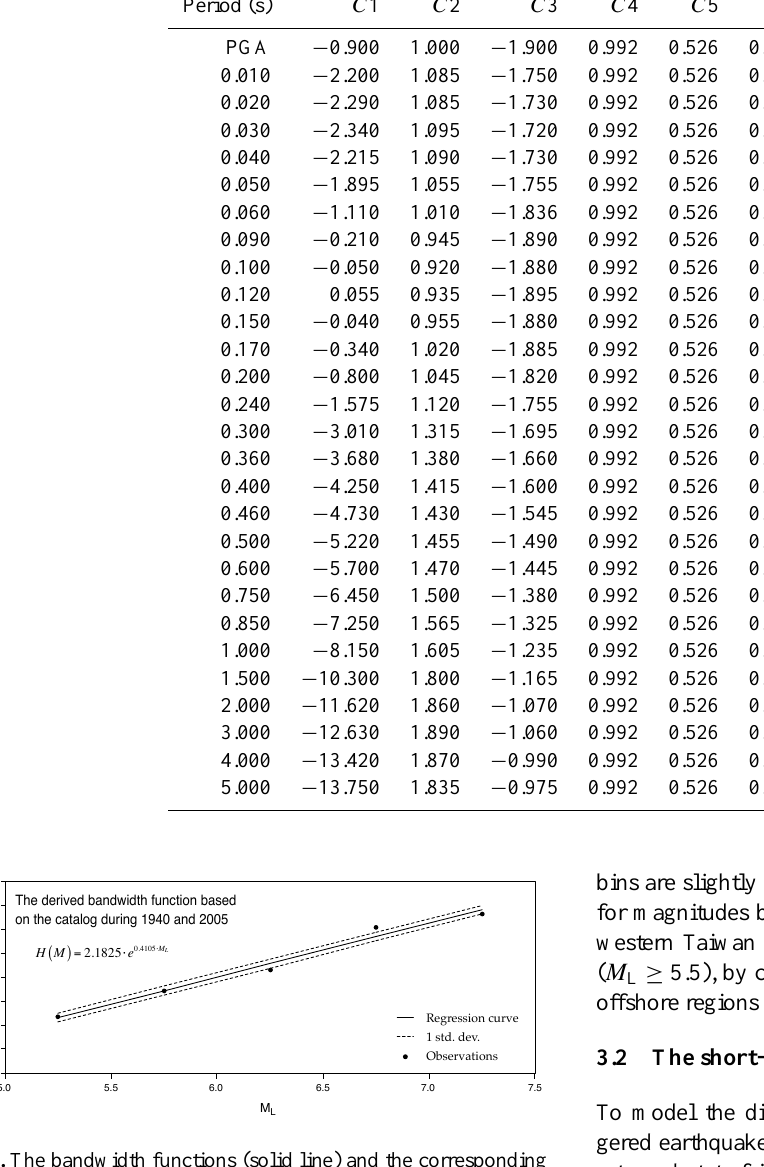
Fig. 3. The bandwidth functions (solid line) and the corresponding standard deviation (dashed lines) obtained by the linear regression of observations (black